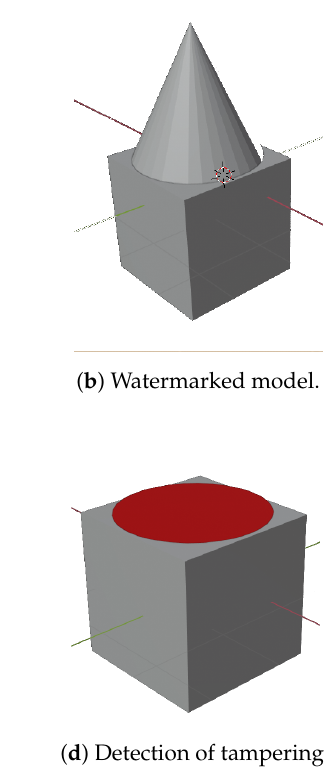
Figure 5. Application of the proposed algorithm to a simplified